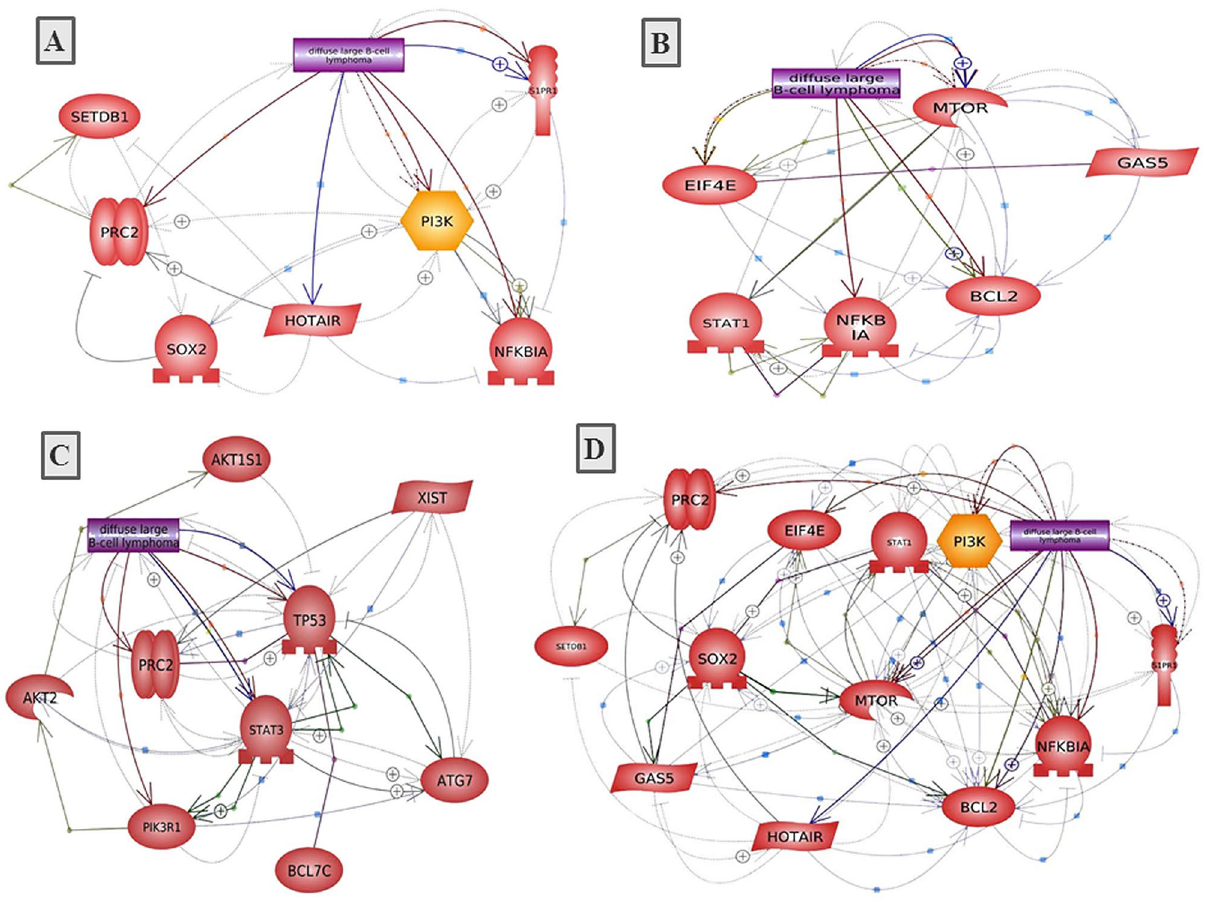
Figure 6. Construction of lncRNA-related PPI networks linked to drug responsiveness in DLBCL. ( A ) HOTAIR, ( B ) GAS5, ( C ) XIST, ( D ) HOTAIR + GAS5. Pathway Studio online software was